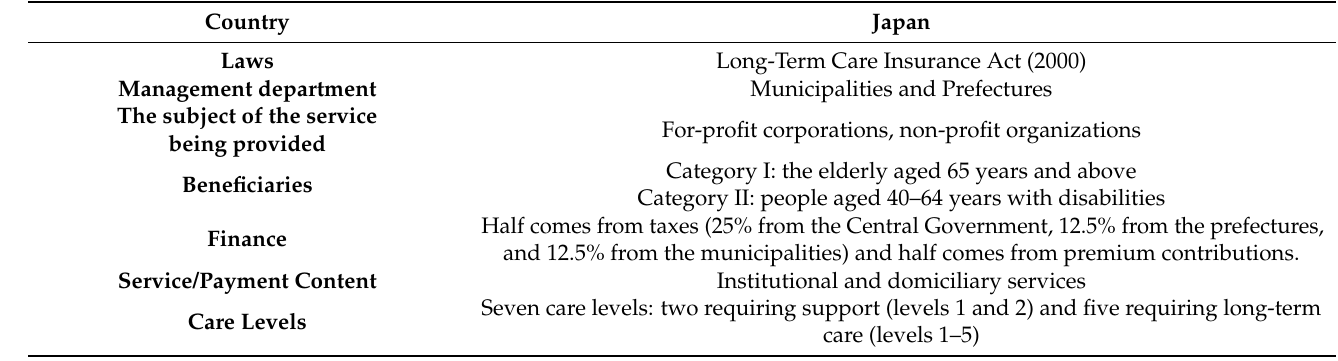
Table 1. The long-term care insurance system in